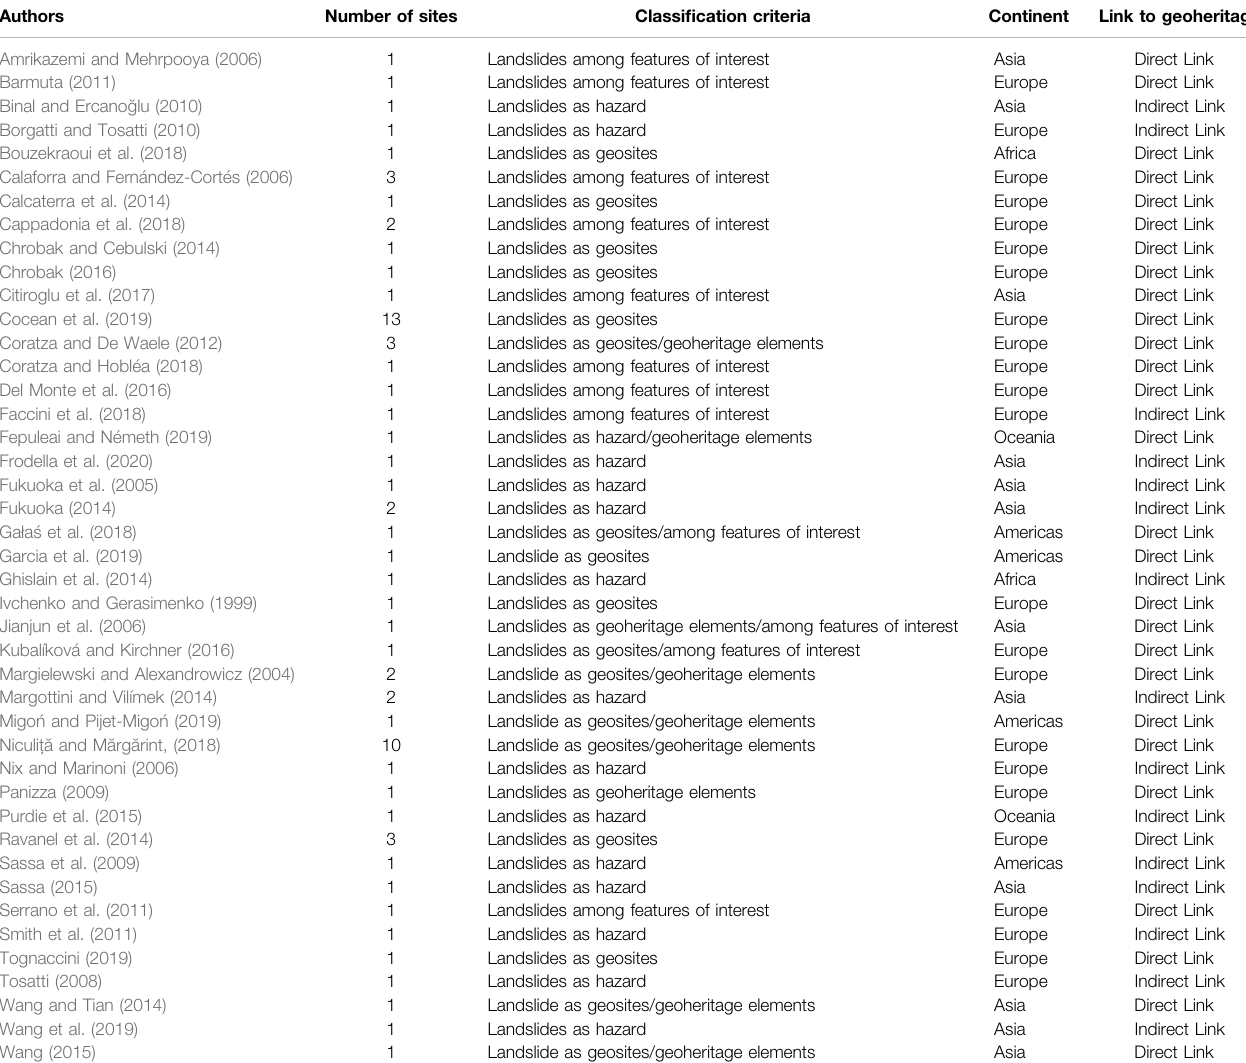
TABLE 2 | Studies reporting on sites that show Direct or Indirect link between landslides and the geological